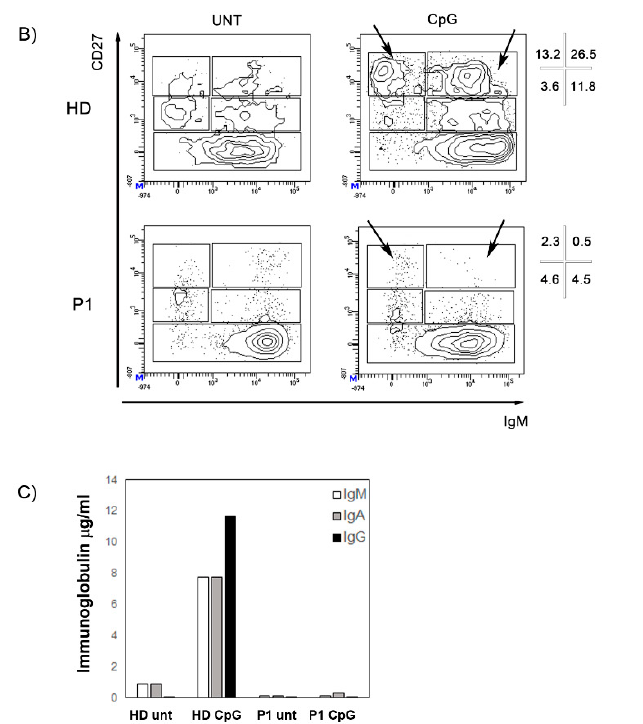
Figure 4. Stimulation with CpG. ( A ) The histograms represent B cell proliferation in a healthy control and P1. B cells were loaded with CFSE dye. The intensity of fluorescence decreased with cell division. The numbers indicate the percentage of B cells that had proliferated. ( B ) CD27 and IgM expression is determined in P1 and in a healthy donor with or without the addition of CpG (untreated, UNT). Di ff erent B cell populations can be recognized—CD27- mature / naive B cells, IgM + CD27 + memory B cells, IgM-CD27 + switched-memory B cells, and CD27bright plasmablasts (either IgM + or IgM − , arrows). Percentages of these subpopulations in the CD19 + B cells gate are indicated. Black arrows indicate plasmablasts. ( C ) IgM (white columns), IgA (grey columns), and IgG (black) concentration ( µ g / mL) in the supernatants after 7 days of stimulation with CpG in a healthy control and in